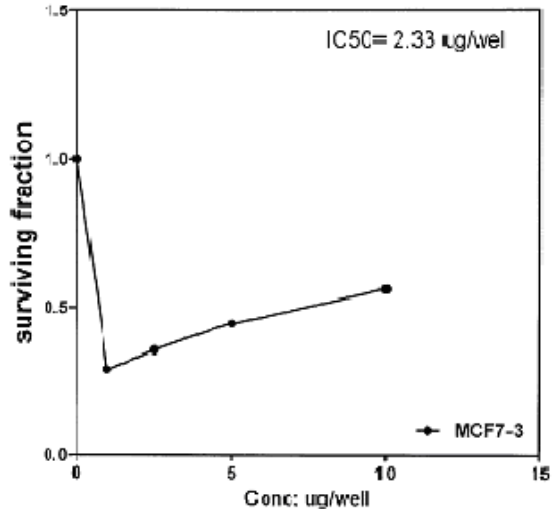
Figure 4. Effect of conc. of 14a on MCF-7 line.